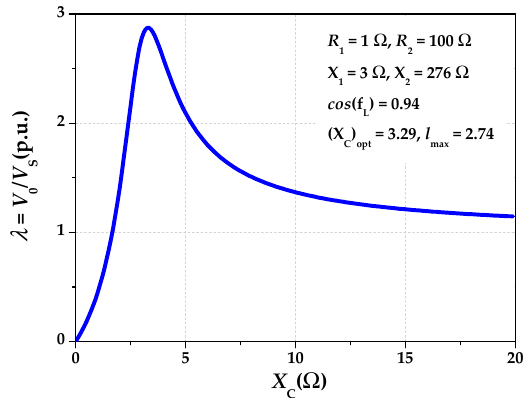
Figure 5. The ratio between output and input voltages as a function of reactance ( 𝑋 (cid:3004) ). The optimal value of 𝑋 (cid:3004) corresponds to the maximum voltage amplification ( λ ) can be calculated using preliminary transformations in Equation (2):